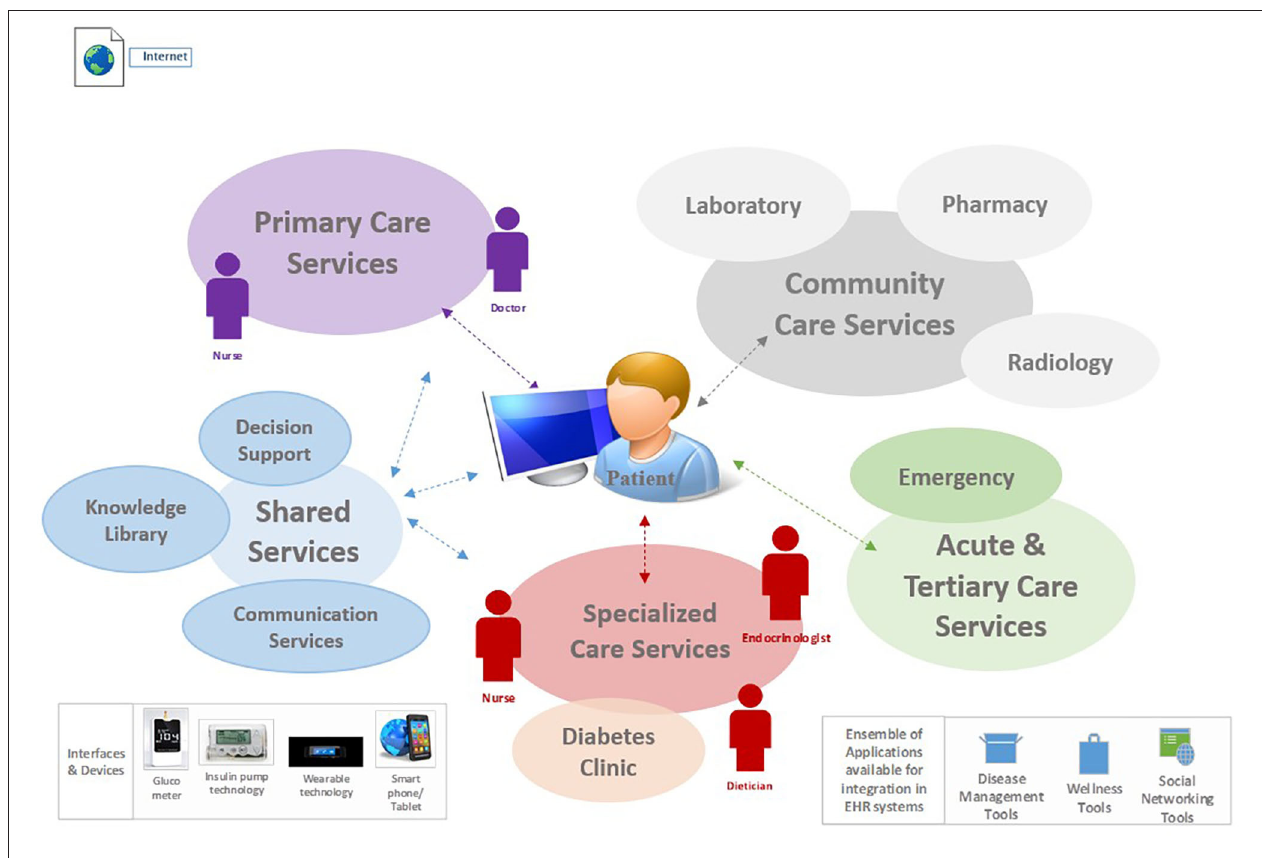
FIGURE 1 | e-PHR ecosystem.